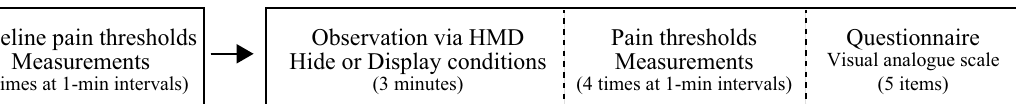
Figure 2. Experimental procedure. After pretesting to measure the baseline pain thresholds, we performed the experimental block in both conditions in random order (within-subject